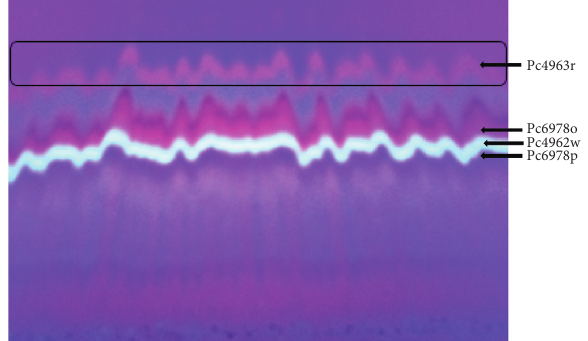
Figure 5: Preparative TLC chromatogram. The chromatogram shows that at least four chromatograms (Pc4963r, Pc4962w, Pc6978p, and Pc6978o) migrated to different positions as visualized under UV.